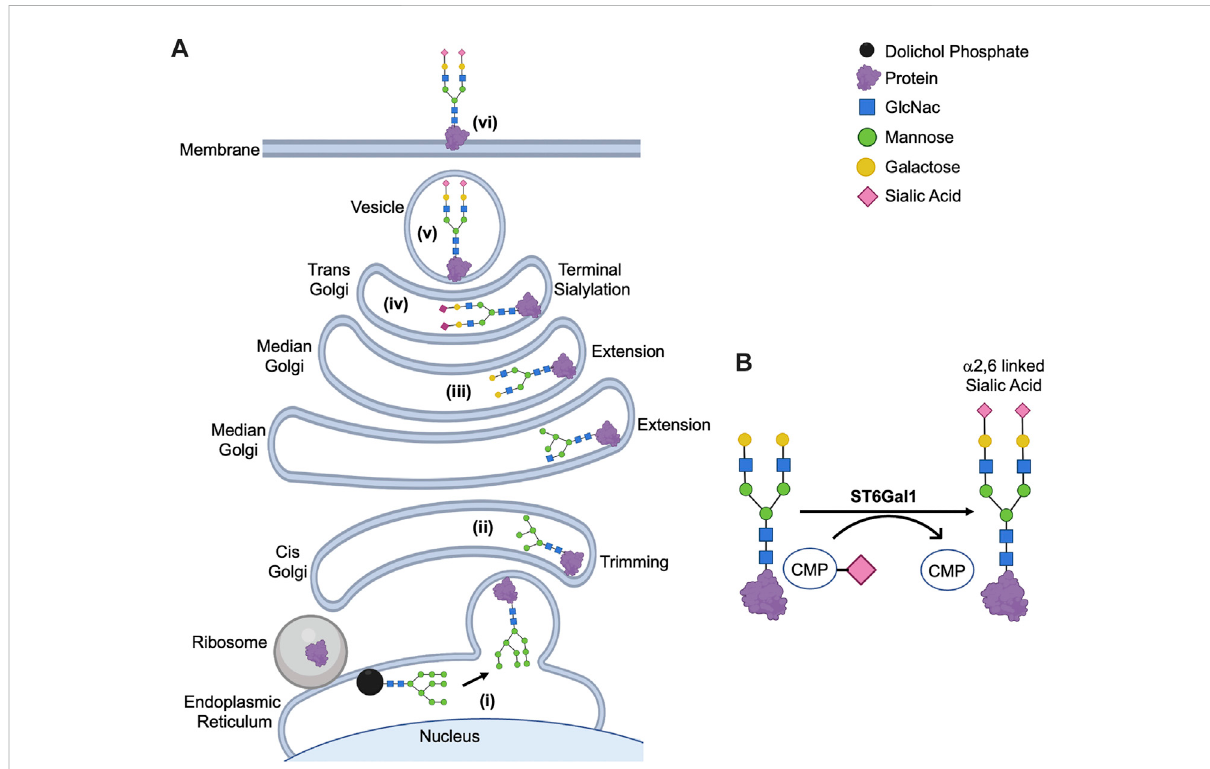
FIGURE 1 PosttranslationalModi fi cationofN-GlycoproteinsinGolgi. (A) Matureglycanlinkedtodolicholphosphateisaddedtotheproteinsynthesizedin rough endoplasmic reticulum (i). The glycoproteins are modi fi ed via trimming in cis-Golgi (ii), extension in median Golgi (iii) and terminal sialylation by ST6Gal1 among other sialyltransferases in trans-Golgi (iv). The mature proteins are transported in vesicles (v) to the membrane (vi). (B) ST6Gal1 adds α 2,6 linked terminal sialic acid to the N-linked glycoproteins using CMP-Sialic acid as a donor. The schematic diagram was created using Biorender